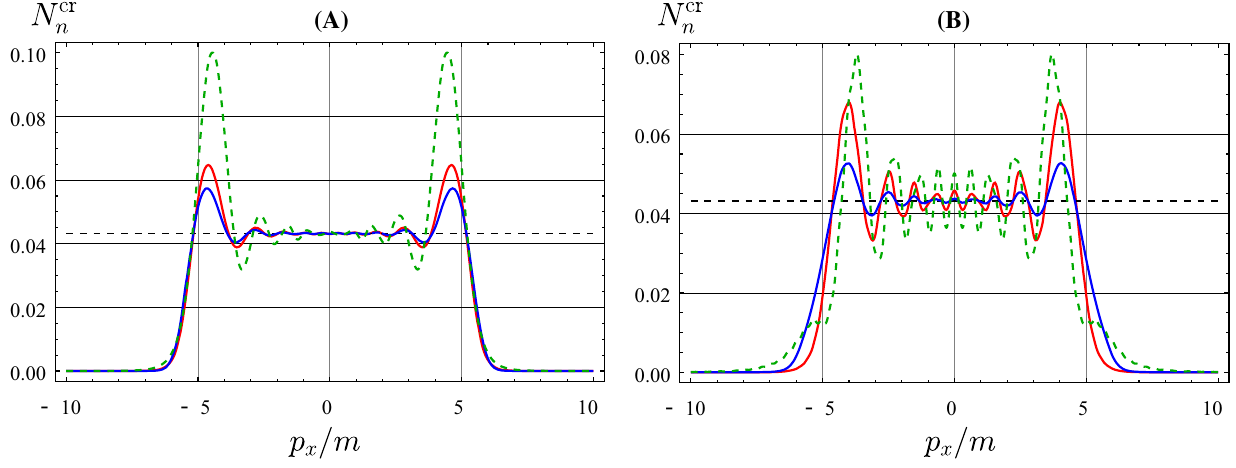
Fig. 7 Differential mean number of Fermions ( a ) and Bosons ( b ) created from the vacuum by electric fields. The solid red and blue lines refers to the composite fields (51) and (62), respectively, with τ = τ = τ and k = k = k . The dashed green lines refers to the 1 2 1 2